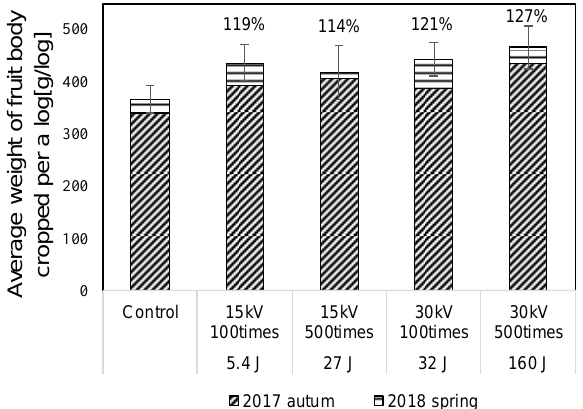
Figure 14. Average yield of fruit body fruitbody of Lyophyllum deeastes Sing per a log for 2 flush seasons.